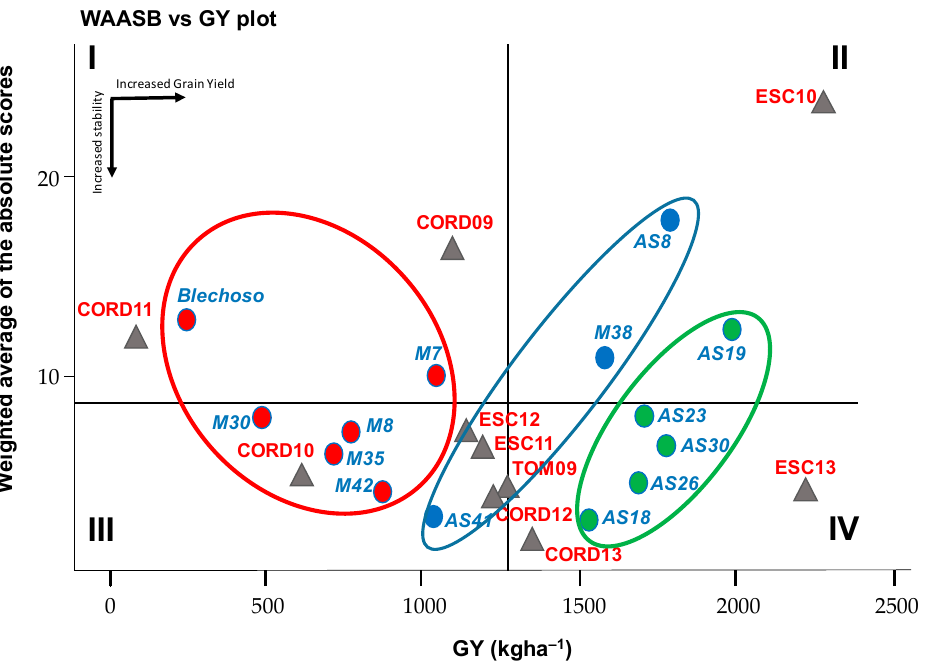
Figure 1. Biplot of grain yield vs. WAASB of 14 chickpea genotypes evaluated in 10 environments. Horizontal black arrows indicate the direction of the increase in grain yield; vertical arrow indicate increase of stability. Triangle for environments and circle with different colors for genotypes. Groups of genotypes with similar performance regarding stability and performance in ellipses according to cluster analysis of the ranking matrix from the 50/50 to the 0/100 scenarios for the WAASB/GY ratio.